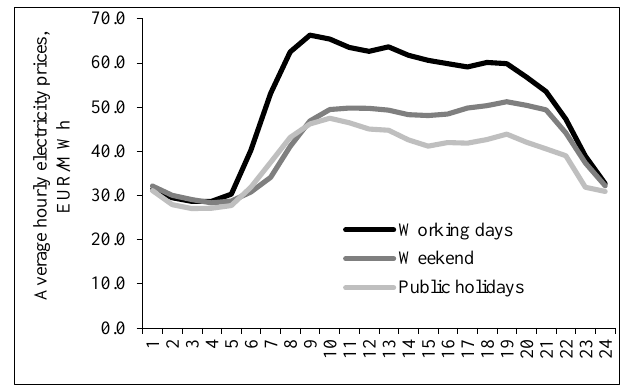
Fig. 4. Average hourly electricity price profiles (Nord Pool Spot, 2016).